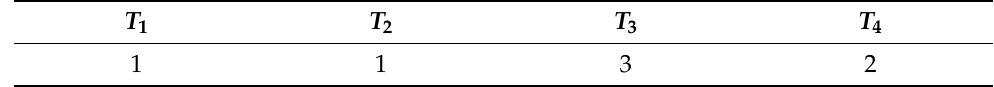
Table 2. An illustration of task scheduling. T 1 T